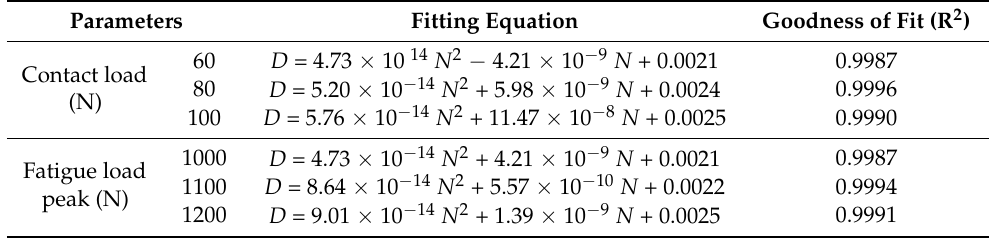
Figure 4. Fitting curves of damaged wire (pair: groove) damage degree under different contact loads ( a ) and different fatigue loads ( b ). Table 3. Fitting equation for damage degree of the fatigue wire (pair: groove).